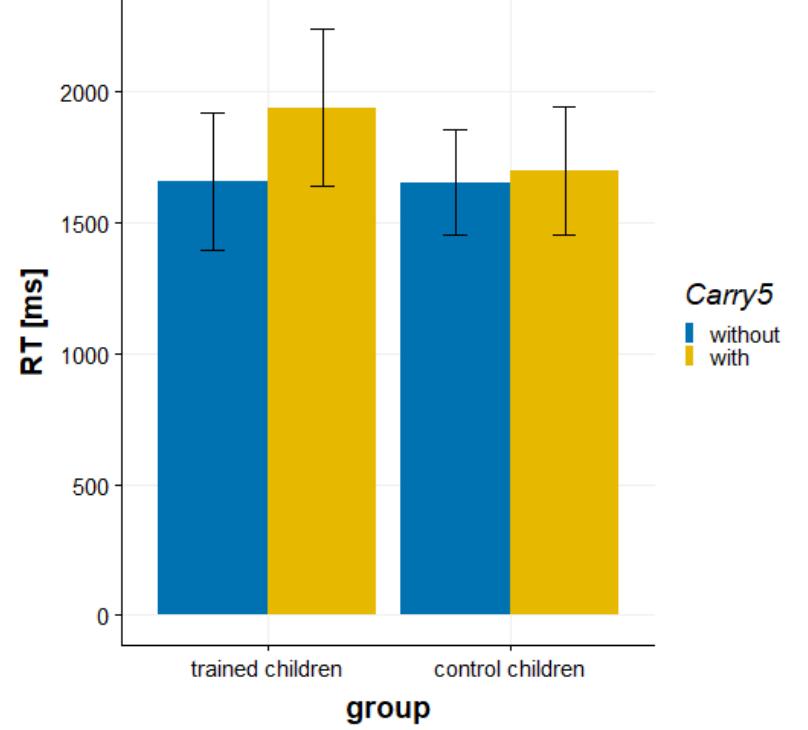
Figure 2. Behavioral data of the addition task. Trained children but not control children showed a subbase-5 effect in RT. Error bars indicate 95% CI .